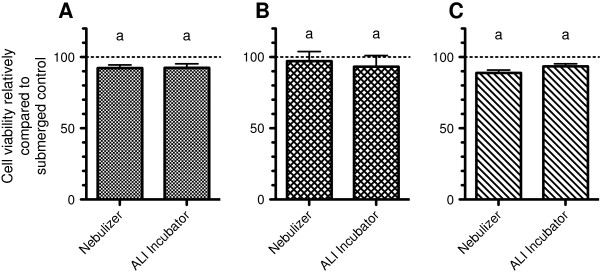
Viability of cultures exposed to an aerosol of PBS by using the Vitrocell™ aerosol exposure system. Cultures were exposed to an aerosol of PBS for 30 min using the Vitrocell™ aerosol exposure system. A: A549 monoculture; B: Coculture of A549 and EA.hy 926 cells; C: Tetraculture. The dotted line represents the viability of cells kept under submerged conditions to which the ALI samples were compared. Data represents the mean of four independent transwell inserts ± SEM. Groups that are sharing the same letters are not significantly different (P > 0.05).